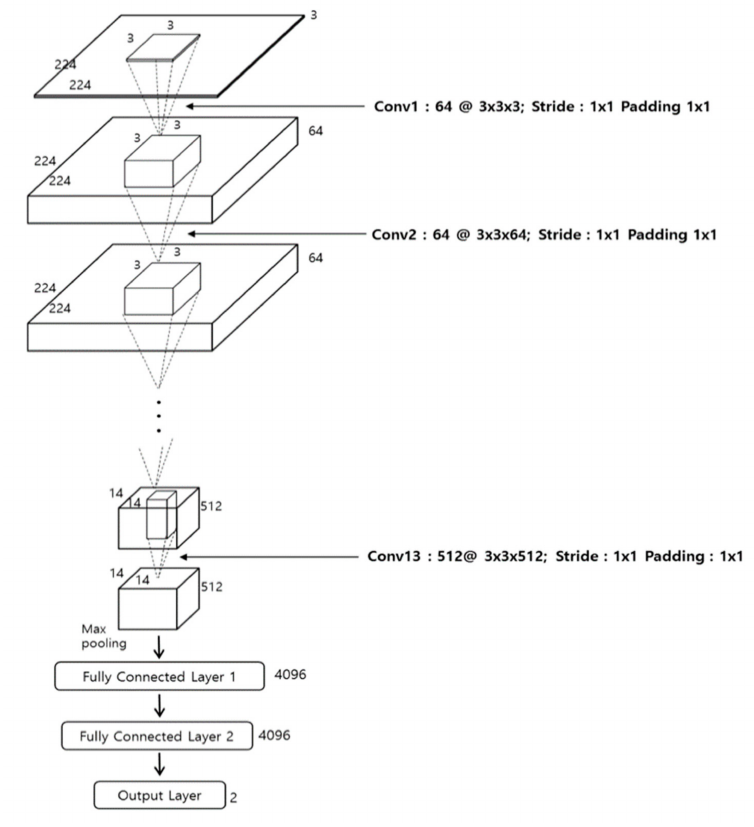
Figure 3. VGG Net-16 architecture used in our